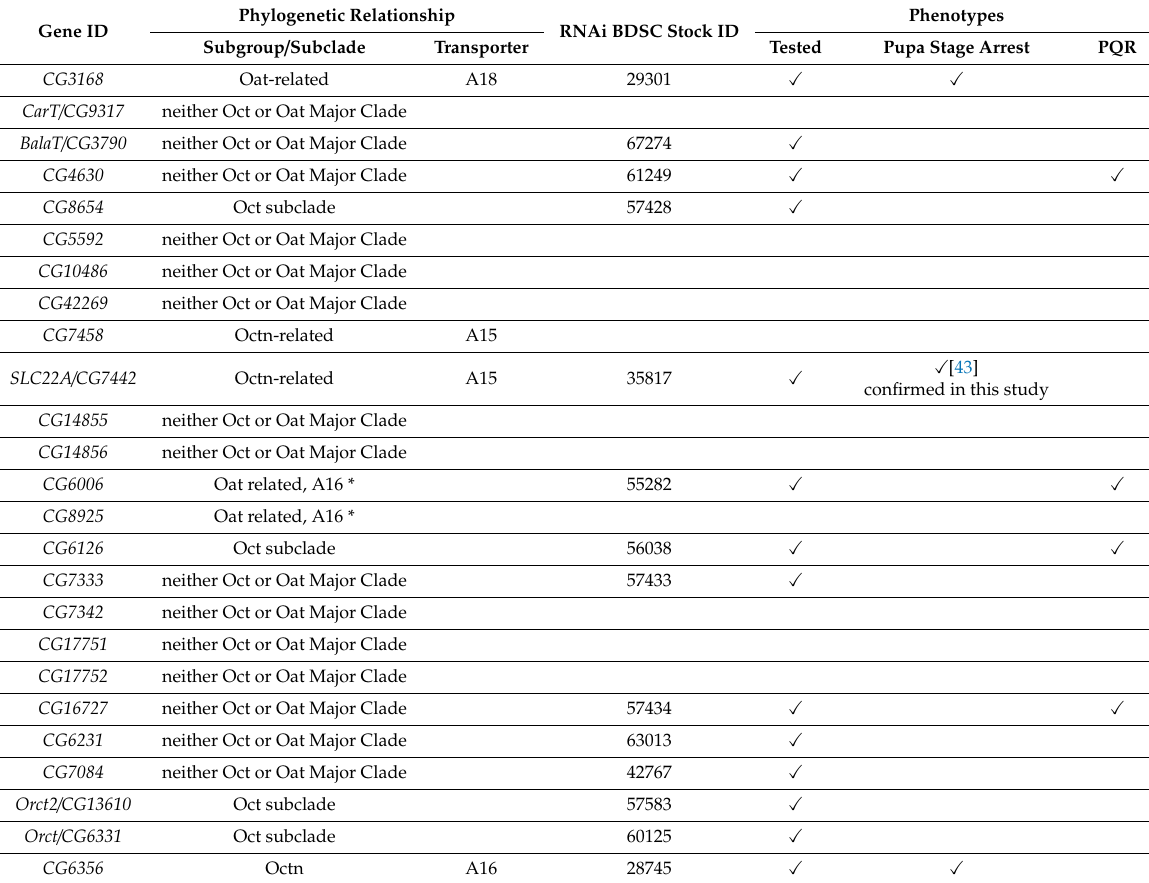
Table 2. Sequence alignment and functional analysis of SLC22 in Drosophila Melanogaster . (cid:88) addresses column